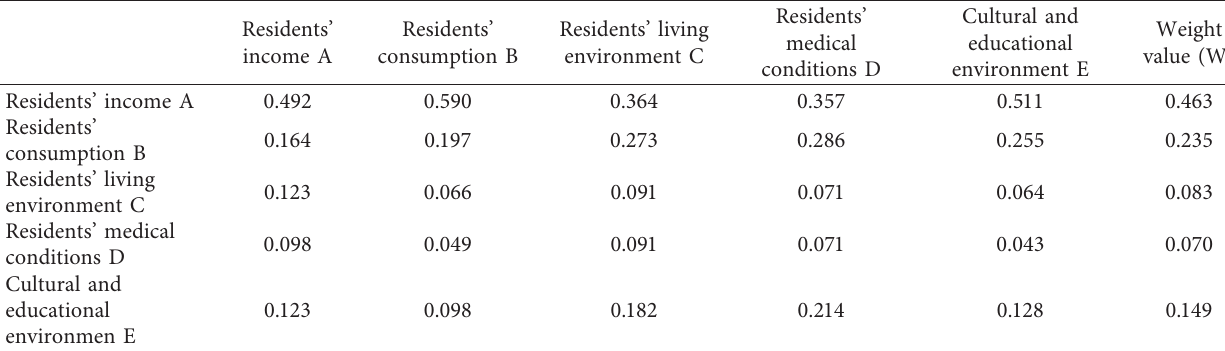
Table 6: Results of the primary index weight